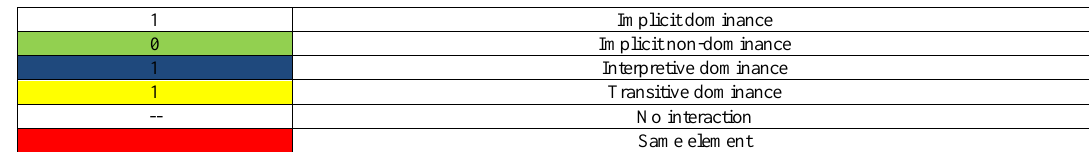
Table 24. Color scheme.